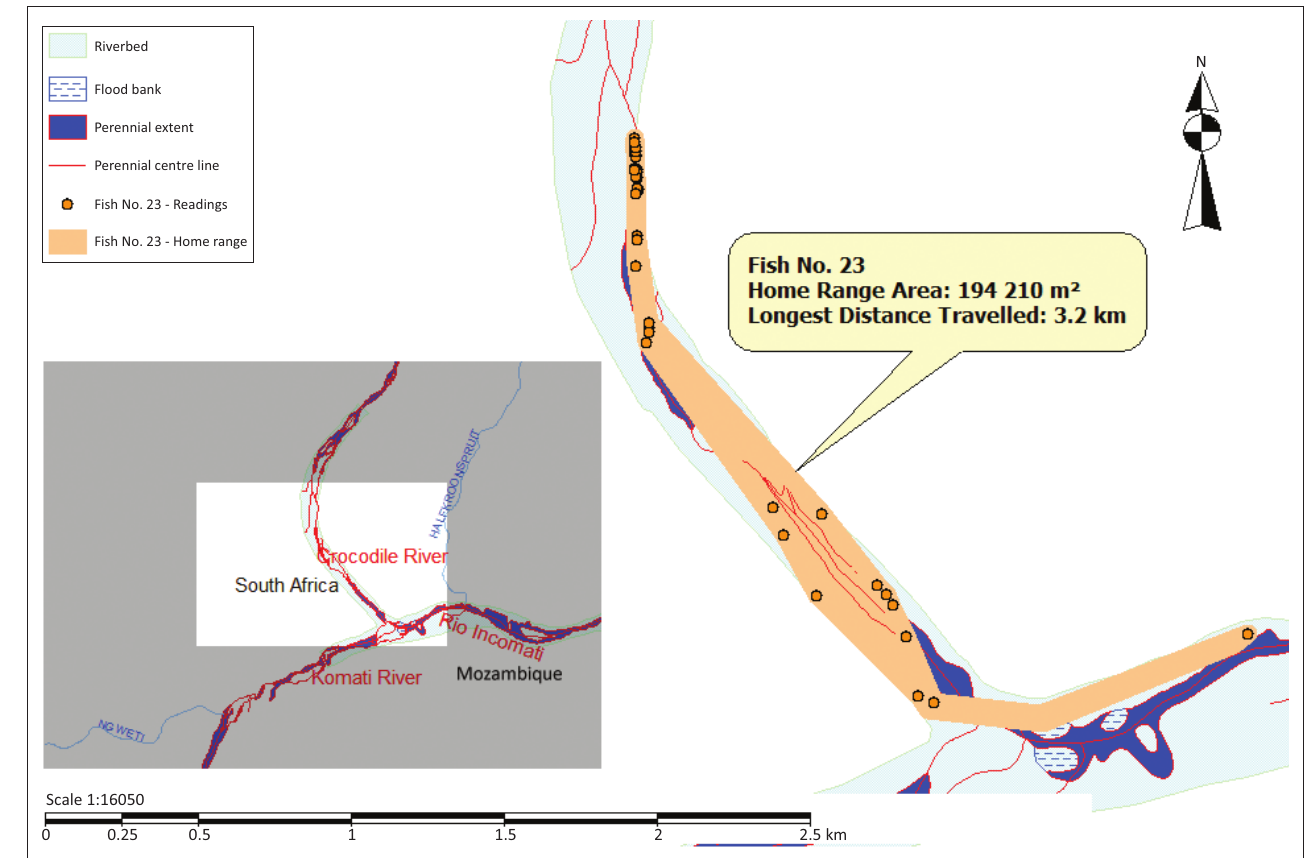
FIGURE 10: Map of radio-tagged fish number 23 indicating home range and longest distance travelled (Type 3 movement